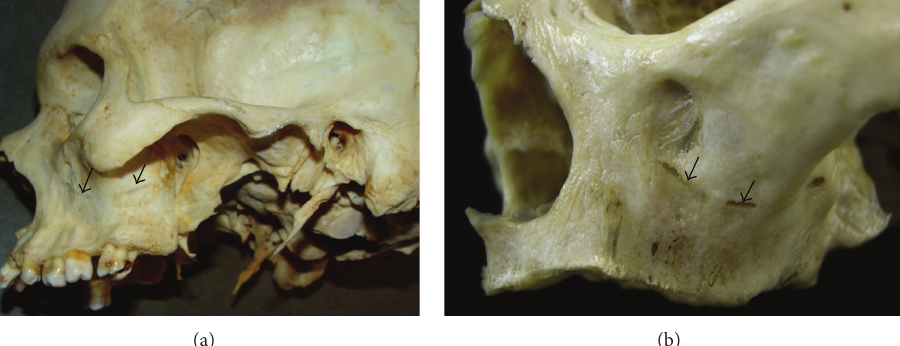
Figure 5: Route of the bony canal in the dry skulls (black arrows). (a) A tunnel route; (b) an extraosseous and intraosseous route (fragmented route).